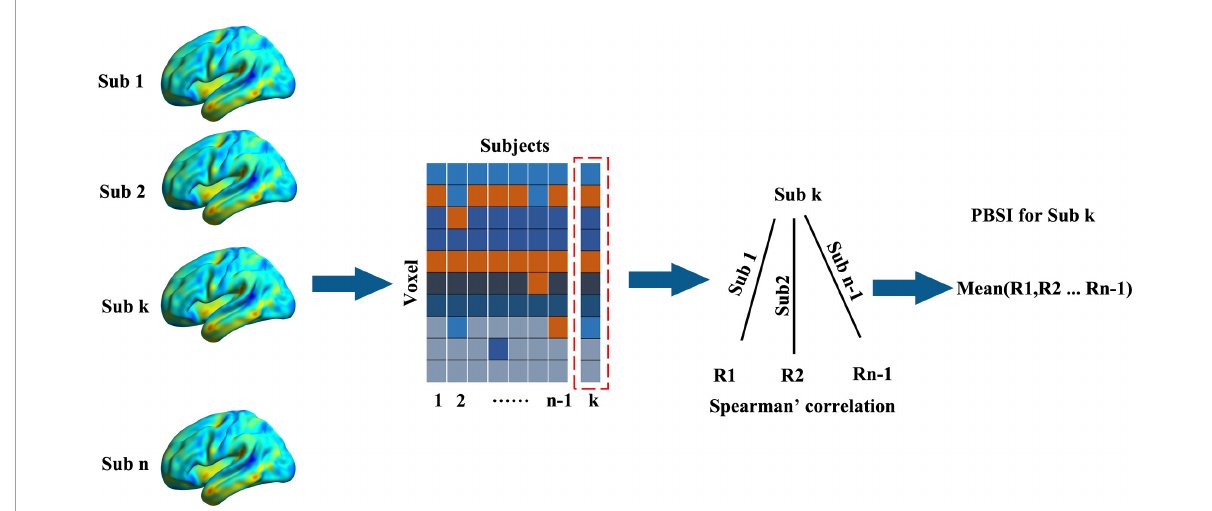
FIGURE1 The work flow of calculating the person-based similarity index. The voxel-wise gray matter volumes were concatenated into vectors (voxel × subjects) for one group (the number of subjects was n). For subject k (sub k), the person-based similarity index (PBSI) was the mean Spearman’s correlations (the number was n-1) between it with other subjects.